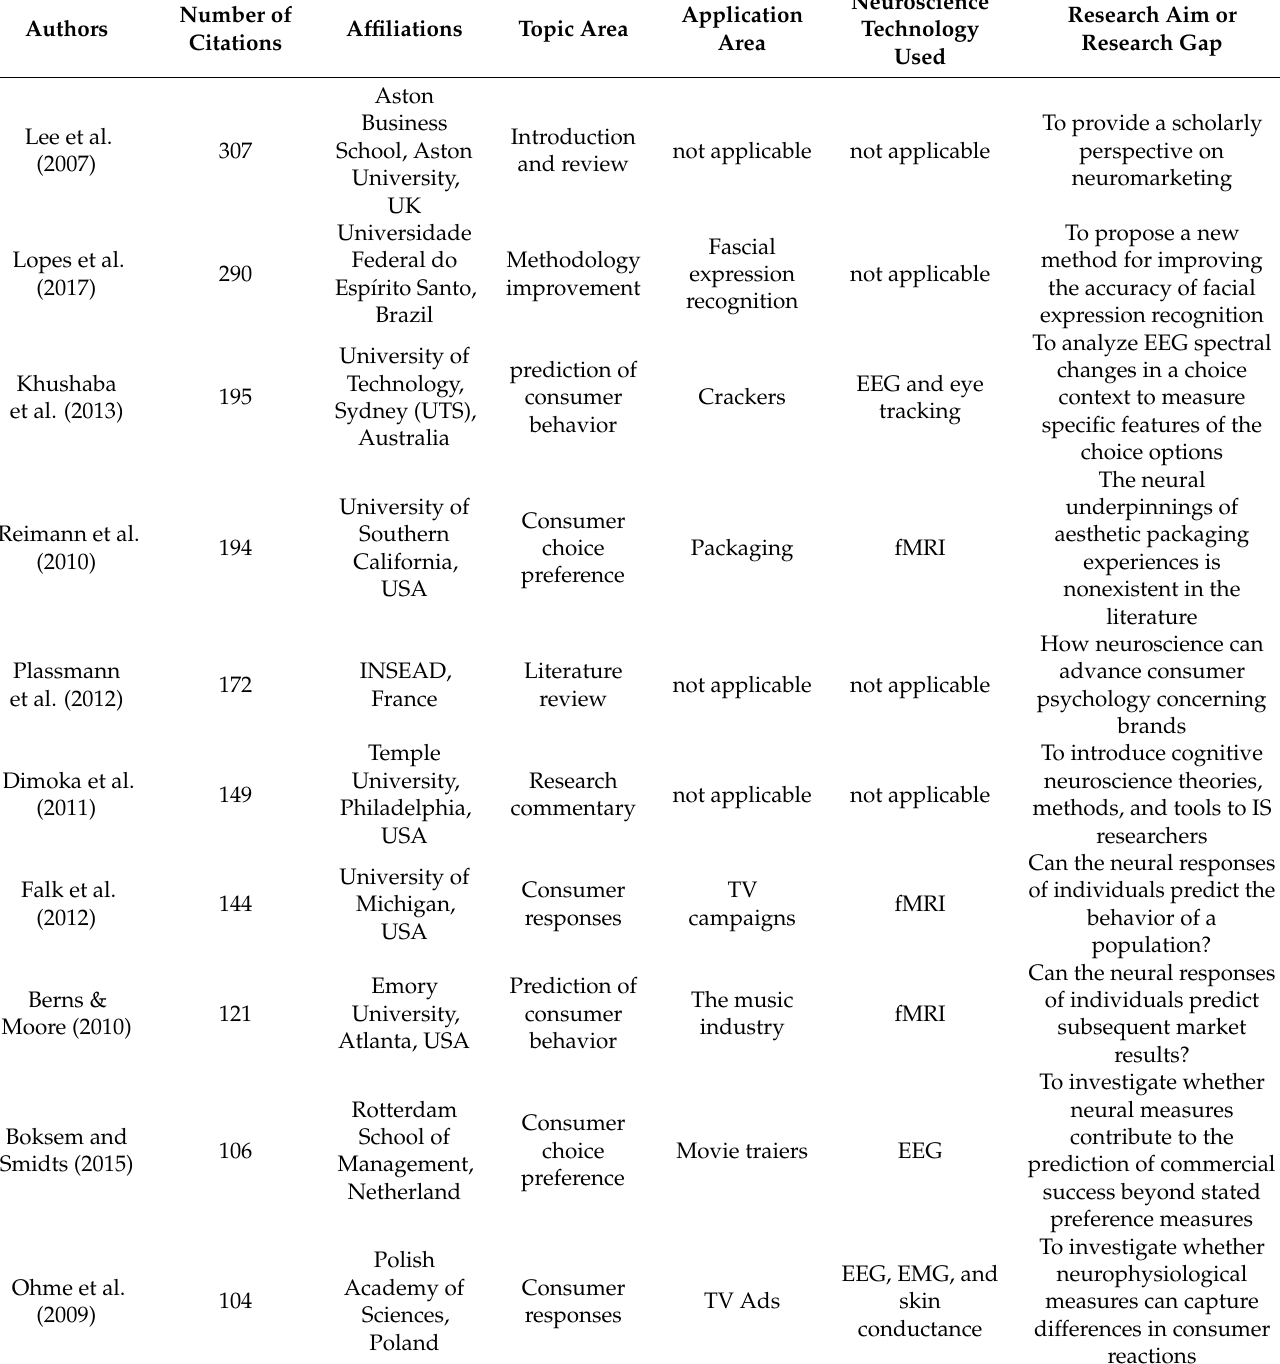
Table 6. Top ten authors in neuromarketing paper